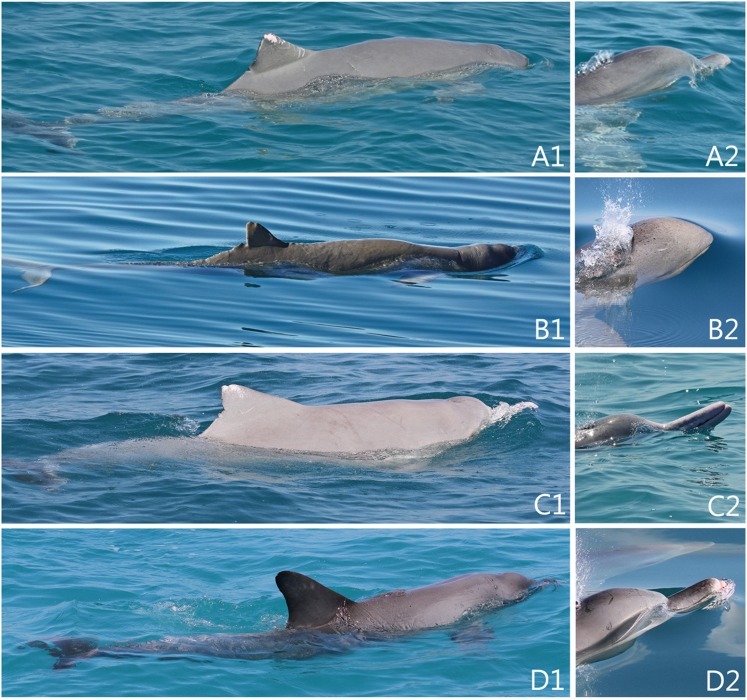
Images of hybrid (A1–2), adult snubfin (B1–2), humpback (D1–2) and bottlenose (D1–2) dolphins encountered at Cygnet Bay.Left images show relative dorsal proportions; right images compare head/rostrum characteristics.